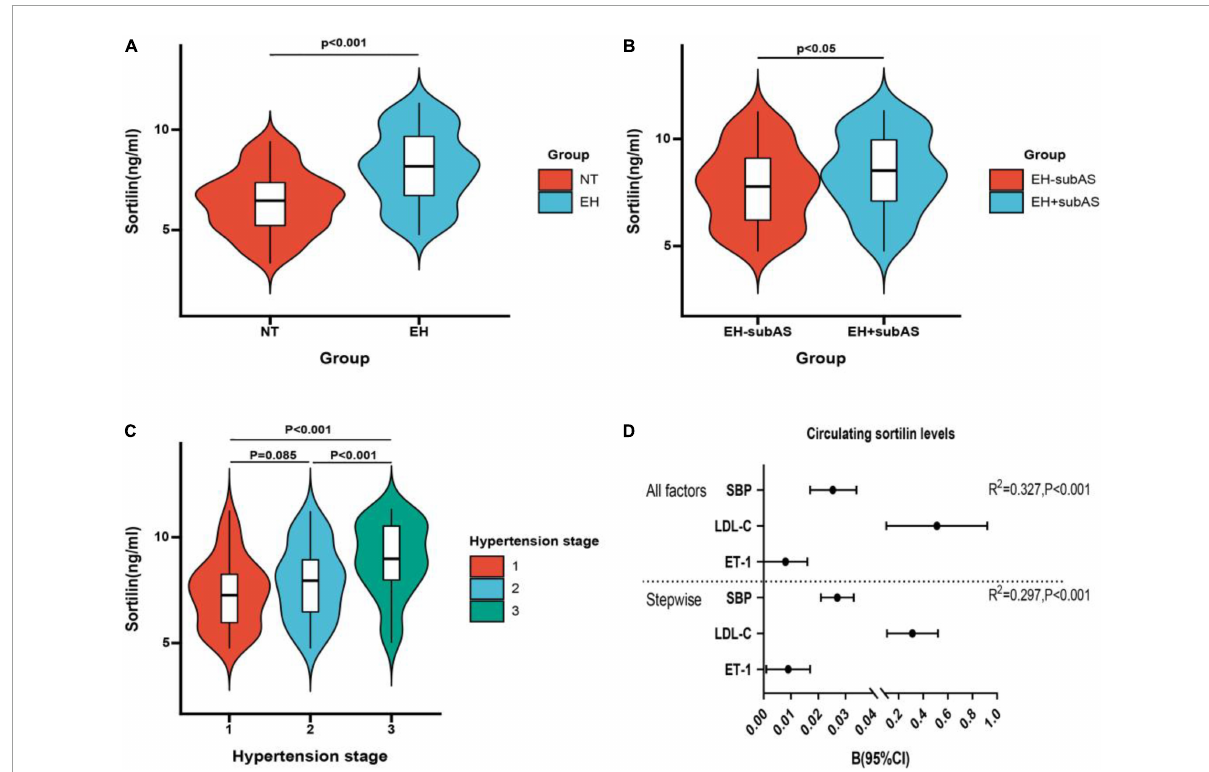
FIGURE1 Concentrations of circulating sortilin in study population. (A) Circulating sortilin levels in the EH and NT groups. (B) Circulating sortilin levels in hypertensive subjects with subclinical carotid atherosclerosis (EH + subAS) or without subclinical carotid atherosclerosis (EH-subAS). (C) Comparison of the concentration of sortilin in different hypertension stages in the EH group. (D) All factors and stepwise multiple regression analyses of circulating sortilin in all study populations. The circles correspond to the regression coefficients β , and the error bars indicate the 95% confidence interval (CI) of β